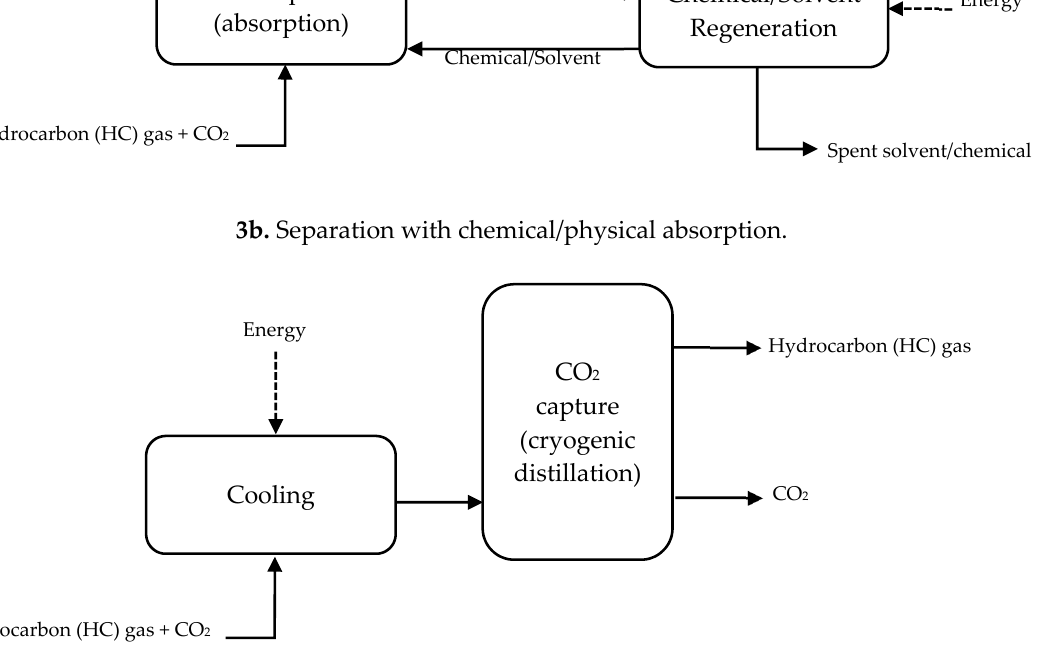
Figure 3. ( a – c ) Basic methods for CO 2 capture from natural gas.